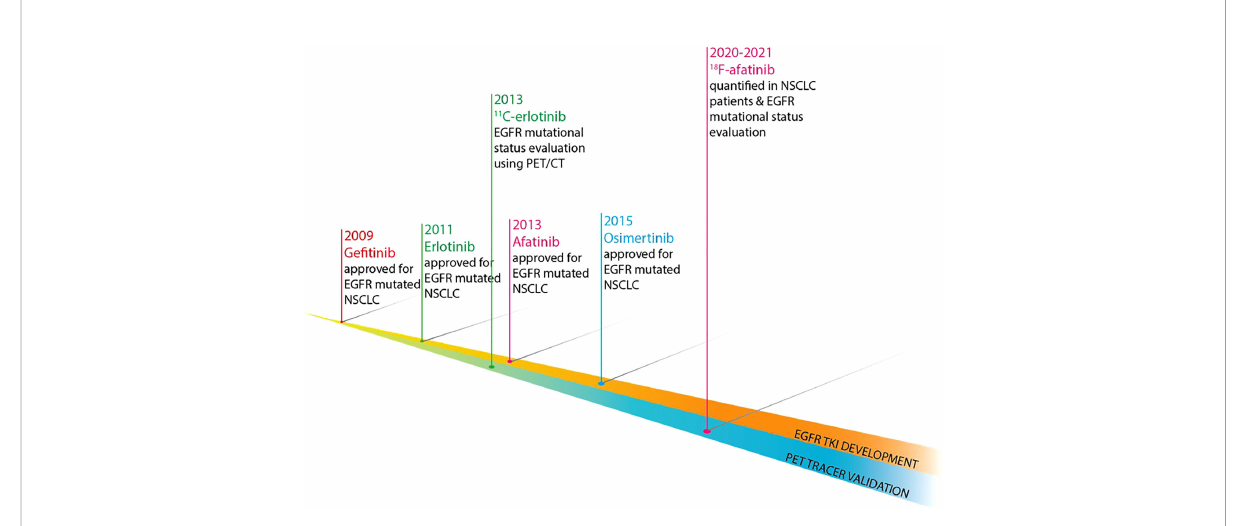
FIGURE 2 Development timeline of EGFR TKI and their respective EGFR-directed PET tracers.